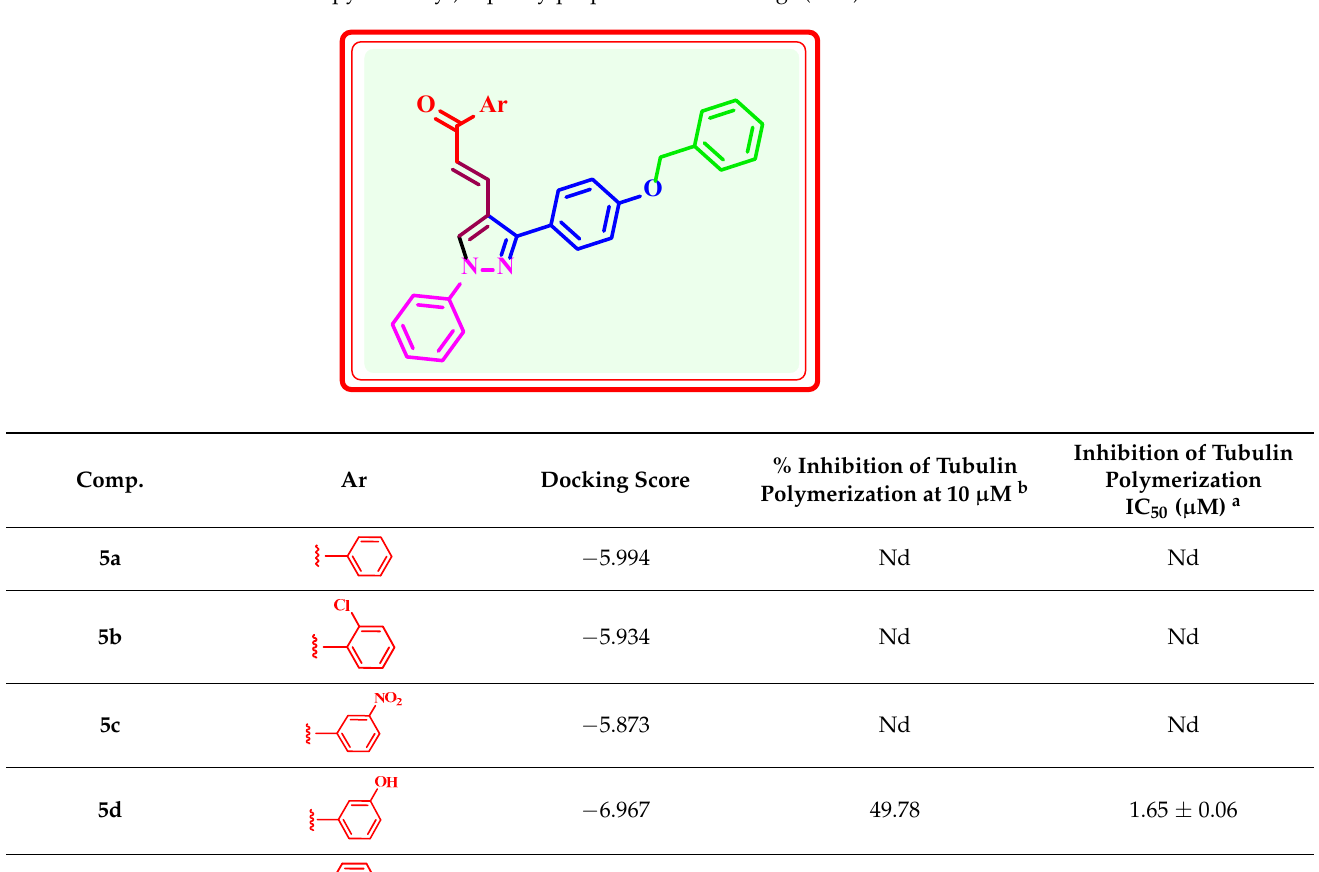
Table 1. Docking score and anti-tubulin activity of E -3-(3-(4-(benzyloxy) phenyl)-1-phenyl-1 H -py-